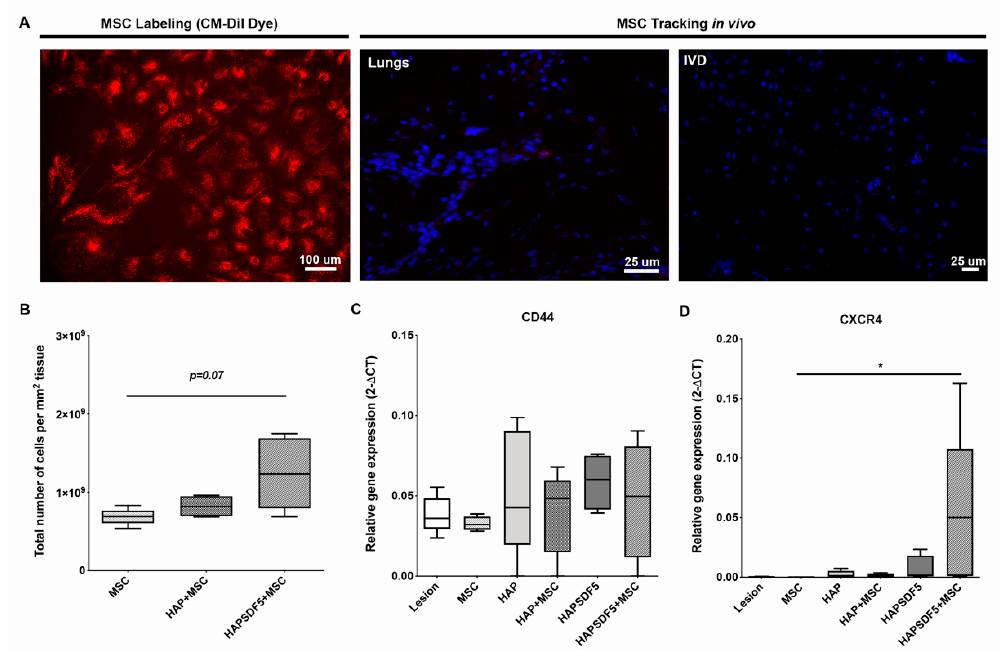
Figure 2. ( A ) rMSC labelling and in vivo tracking. On the left, rMSCs in culture 24 h after CM-DiI labelling (red); on the right, histological sections 2 weeks after administration showing presence of rMSCs in the lungs and the absence of rMSCs in IVD. ( B ) Total number of cells present in IVD identified by DAPI nuclear staining. ( C , D ) IVD gene expression analysis 2 weeks post-injury and intradiscal administrations for the hyaluronic acid receptor CD44 and the SDF-1 receptor CXCR4 normalized to GAPDH. Results are presented as box and whiskers plots (n = 4–5 animals). * p < 0.05.